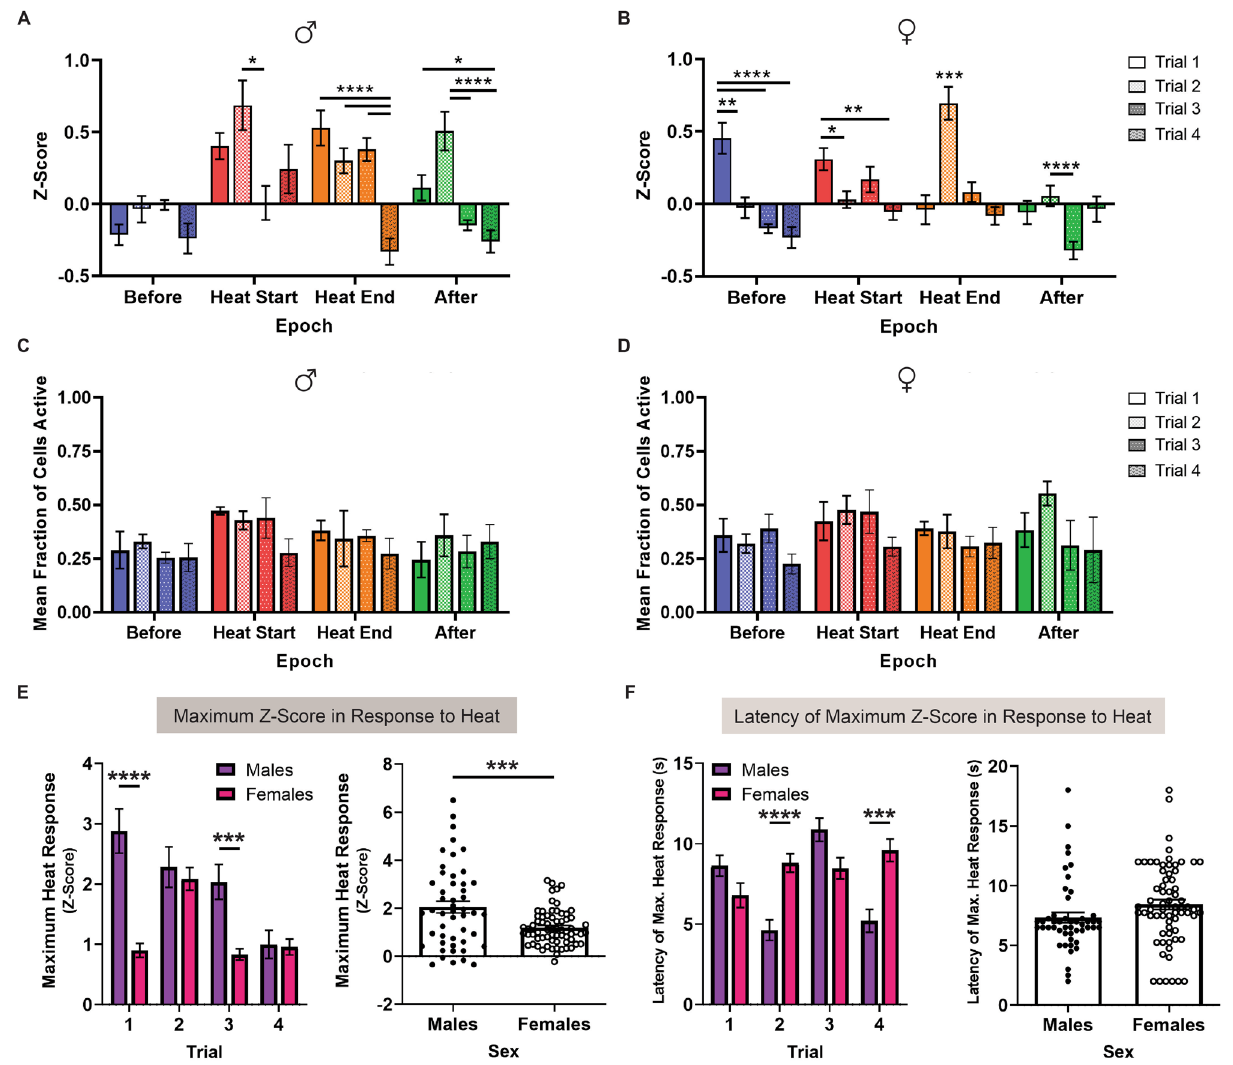
Figure 4. BNST CRF Activity Changes with Repeated Noxious Heat Exposure. (A–B ) Average z-score of BNST CRF neurons by epoch for trials 1–4 in ( A ) male and ( B ) female subjects. Epochs are color-coded: Before (blue), Heat Start (red), Heat End (orange), and After (green) (Males = Two-way mixed-model ANOVA with Sidak’s post hoc: Epoch × Trial interaction [F(4.352, 208.9) = 8.148, P < 0.0001], main effect of Epoch [F(2.375, 114.0) = 16.66, P < 0.0001] and Trial [F(2.822, 135.4) = 10.63, P < 0.0001]; Females = Two-way mixed-model ANOVA with Sidak’s post hoc: Epoch × Trial interaction [F(3.150, 211.0) = 21.05, P < 0.0001], main effect of Epoch [F(1.679, 112.5) = 8.880, P = 0.0006] and Trial [F(2.491, 166.9) = 6.030, P = 0.0014]). ( C–D ) Average neuronal coactivity of BNST CRF neurons by epoch for trials 1–4 in ( C ) male and ( D ) female subjects. Epochs are color-coded with the same system as ( A – B ): Before (blue), Heat Start (red), Heat End (orange), and After (green) (Males = Two-way mixed-model ANOVA with Sidak’s post hoc: no Epoch × Trial interaction [F(1.526, 3.052) = 1.046, P = 0.4252] or main effect of Epoch [F(1.419, 2.838) = 3.149, P = 0.1859] and Trial [F(1.178, 2.355) = 0.5741, P = 0.5447]; Females = Two-way mixed-model ANOVA with Sidak’s post hoc: no Epoch × Trial interaction [F(2.082, 8.329) = 0.9274, P = 0.4366] or main effect of Epoch [F(1.745, 6.981) = 2.102, P = 0.1935] and Trial [F(1.581, 6.326) = 1.041, P = 0.3871]). ( E ) (Left) Maximum z-score response to heat exposure by trial in male (purple) and female (magenta) subjects (Two-way mixed-model ANOVA with Sidak’s post hoc: Trial × Sex interaction [F(3, 345) = 14.96, P < 0.0001], main effect of Trial [F(2.609, 300) = 20.28, P < 0.0001] and Sex [F(1, 115) = 13.69, P = 0.0003]). (Right) Average maximum z-score response to heat in each trial by sex (unpaired t-test: t(115) = 3.70, P = 0.0003). ( F ) (Left) Latency of maximum z-score response to heat exposure by trial in male (purple) and female (magenta) subjects (Two-way mixed-model ANOVA with Sidak’s post hoc: Trial × Sex interaction [F(3, 345) = 16.90, P < 0.0001], main effect of Trial [F(2.717, 312.5) = 7.890, P < 0.0001], no main effect of Sex [F(1, 115) = 3.20, P = 0.0763]). (Right) Average latency of maximum z-score response to heat stimulus in each trial by sex (unpaired t-test: t(115) = 1.789, P = 0.0763). Data are shown as mean ± SEM. * P < 0.05; ** P < 0.01; *** P < 0.001, **** P <